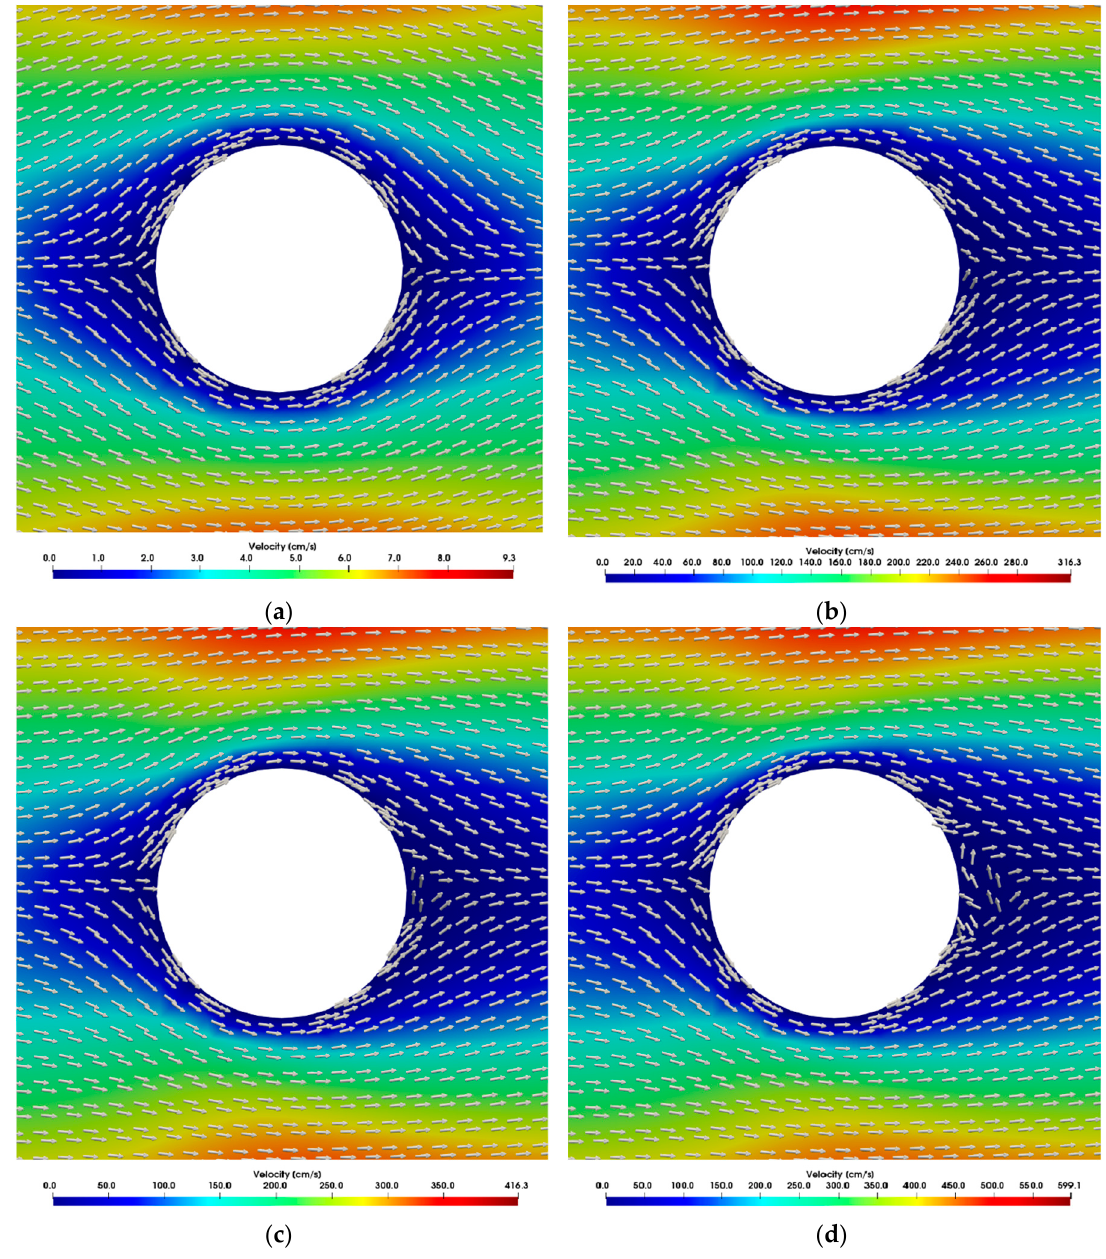
Figure 8. Simulated vector fields between posts at different Reynolds numbers. Static vortices begin to arise with a growing Reynolds number. Color scales refer to the velocity magnitude. The direction of flow is from left to right. ( a ) Re = 0.76, ( b ) Re = 26.67, ( c ) Re = 35, ( d ) Re = 50.